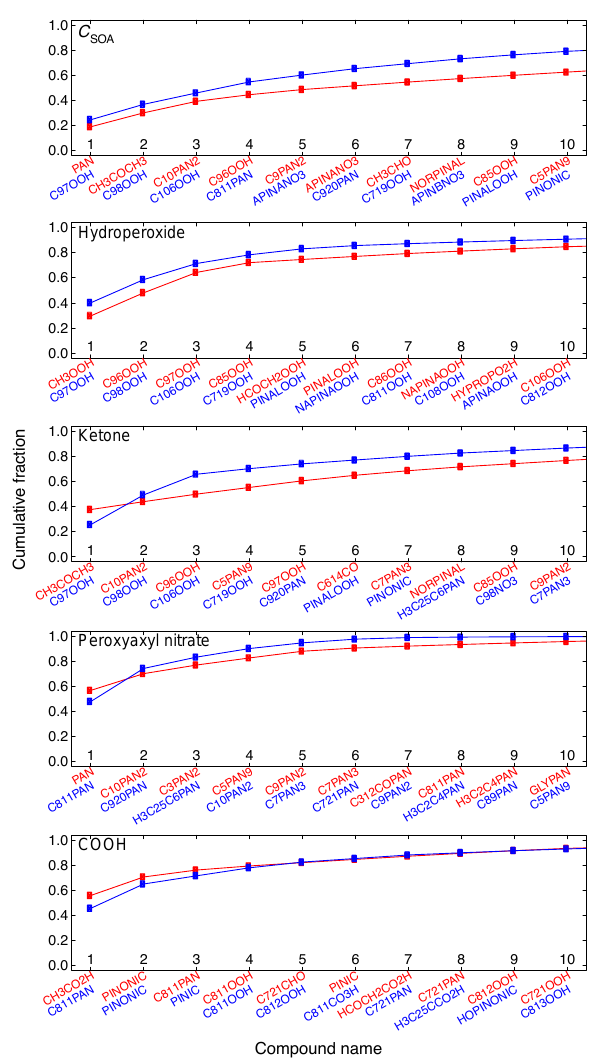
Figure 4. Cumulative contribution (as a fraction of total) of each compound to the overall C SOA mass and abundance of different FG fragments for the APIN-lNO x simulation. Compounds are arranged in order of decreasing contribution in each phase (i.e., first molecule contributes the greatest amount). Contributions to the aerosol phase are shown in blue and the gas phase in red.